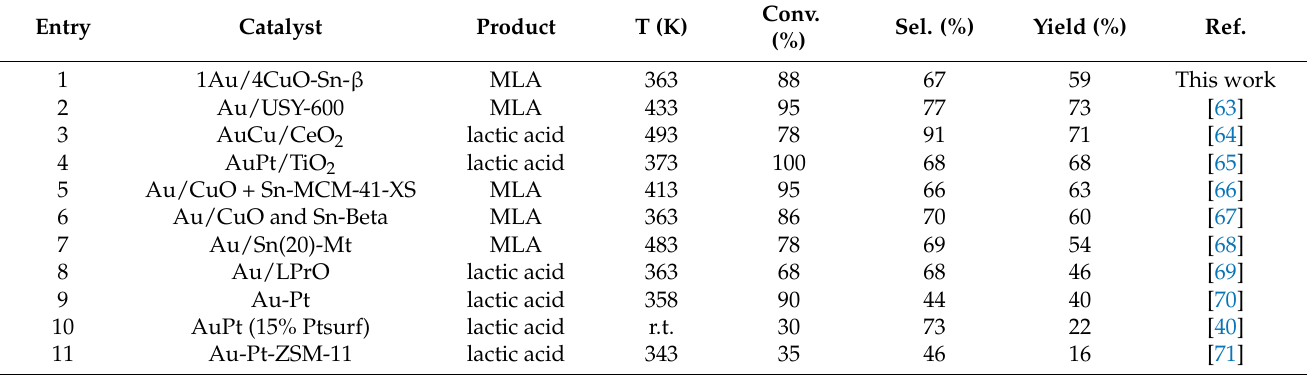
Figure 7. Effect of reaction time on catalytic activity. Table 3. A summary of studies on glycerol oxidation to produce lactic acid or MLA by Au cata- lysts.